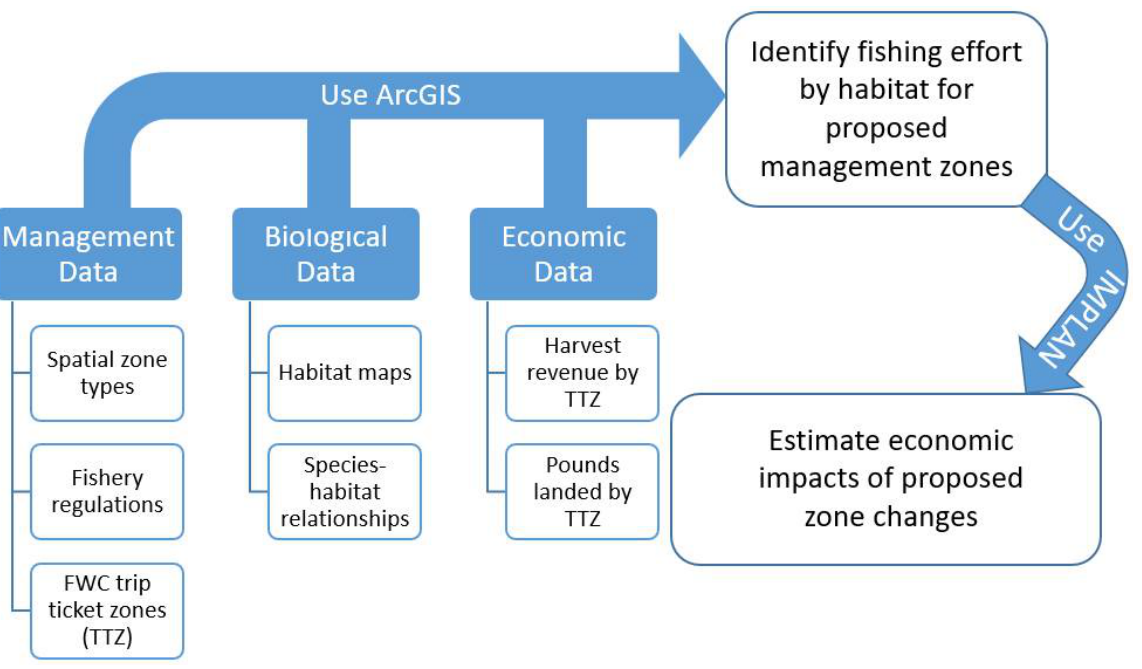
Figure 2. Analysis flowchart. A chart depicting the data used and software to achieve the impact estimates. All data come from secondary sources and is cited in this paper.